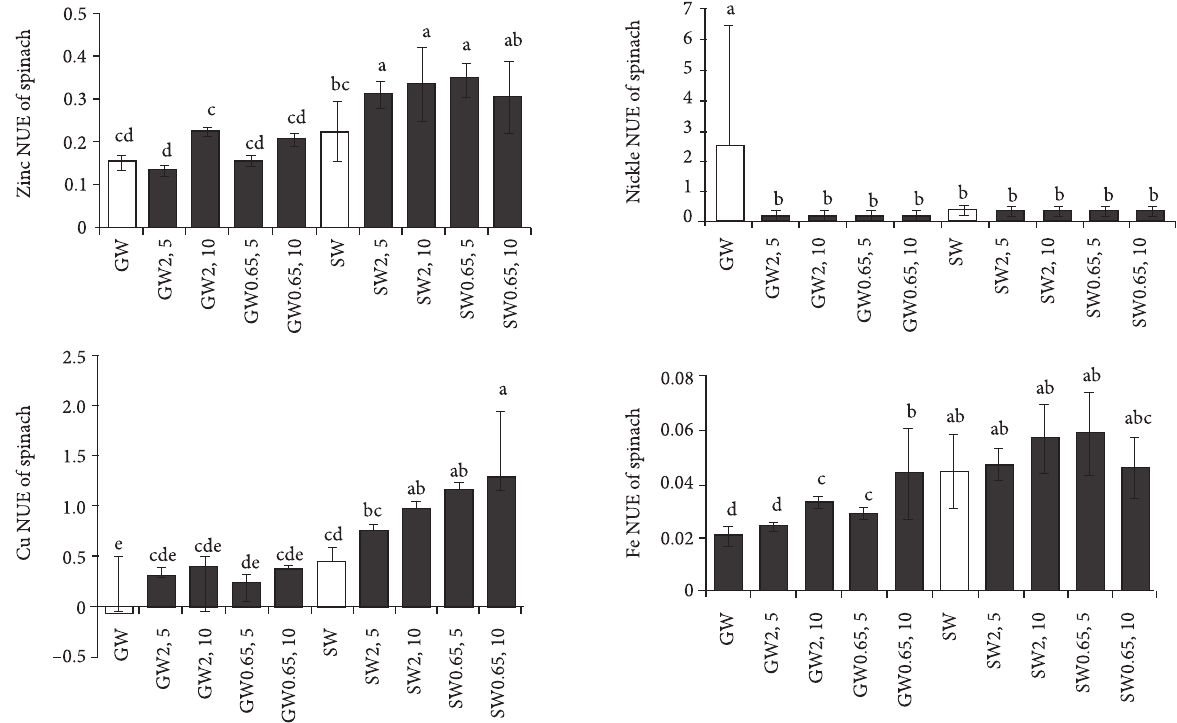
Figure 5. Mean±SD of nutrient use efficiency (NUE) of spinach for heavy metals in response to various treatments; GW-ground water, SW-wastewater, 2, 5-soil amended with large particle size biochar at 5% amendment rate, 2, 10-soil amended with large particle size biochar at 10% amendment rate, 0.65, 5-soil amended with small particle size biochar at 5% amendment rate, 0.65, 10-soil amended with small particle size biochar at 10% amendment rate. Bars with different letters indicate significant difference at P ≤